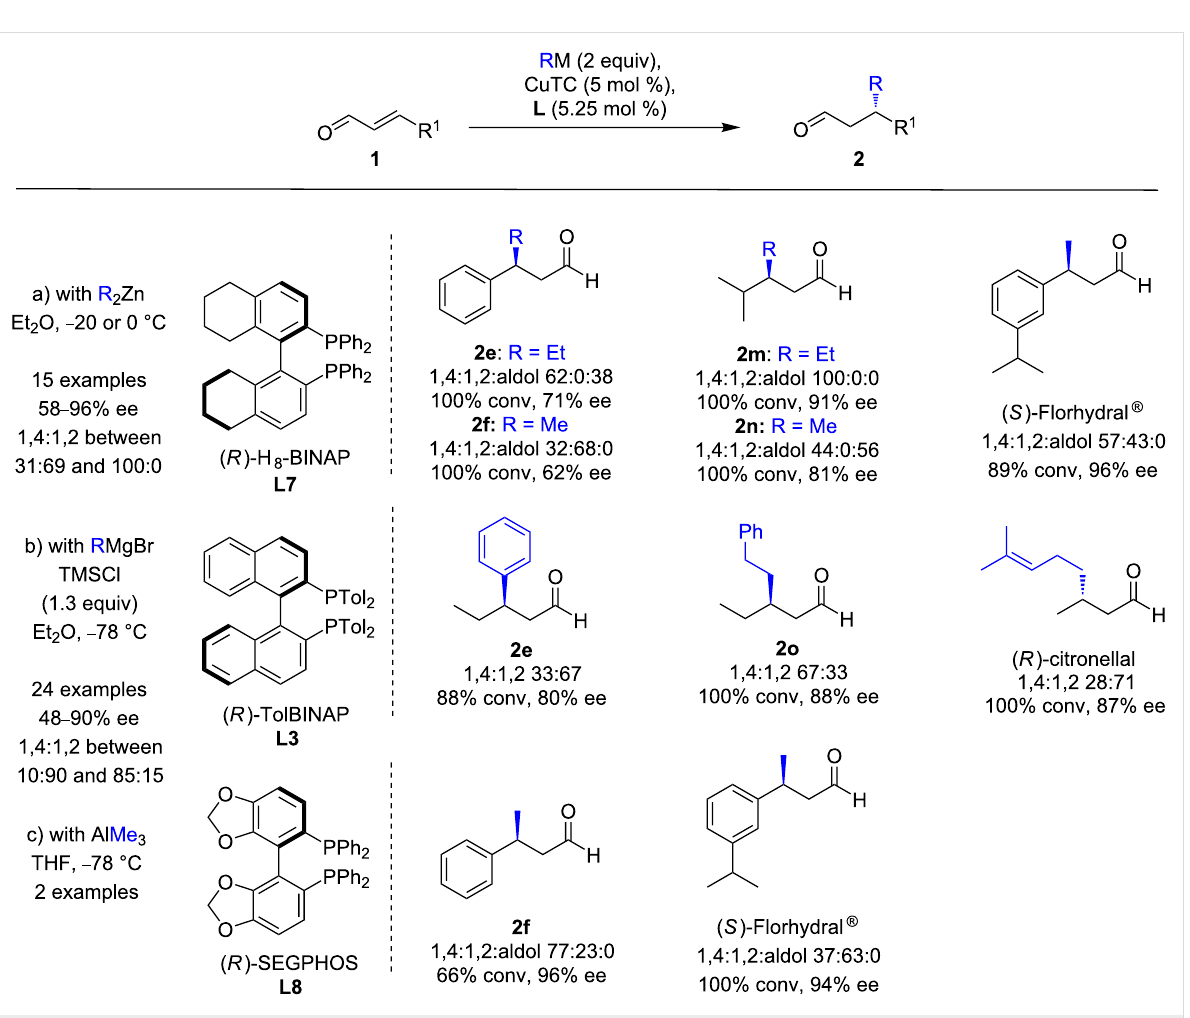
Scheme 5: Optimized conditions for the Cu ECAs of R 2 Zn, RMgBr, and AlMe 3 with α , β -unsaturated